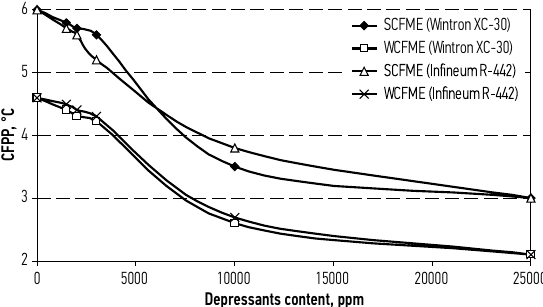
Fig. 4. The dependence of depressant concentration on the CFPP of fuel mixtures containing fatty acid methyl esters of Camelina sativa oil and pork lard (SCFME and WCFME)